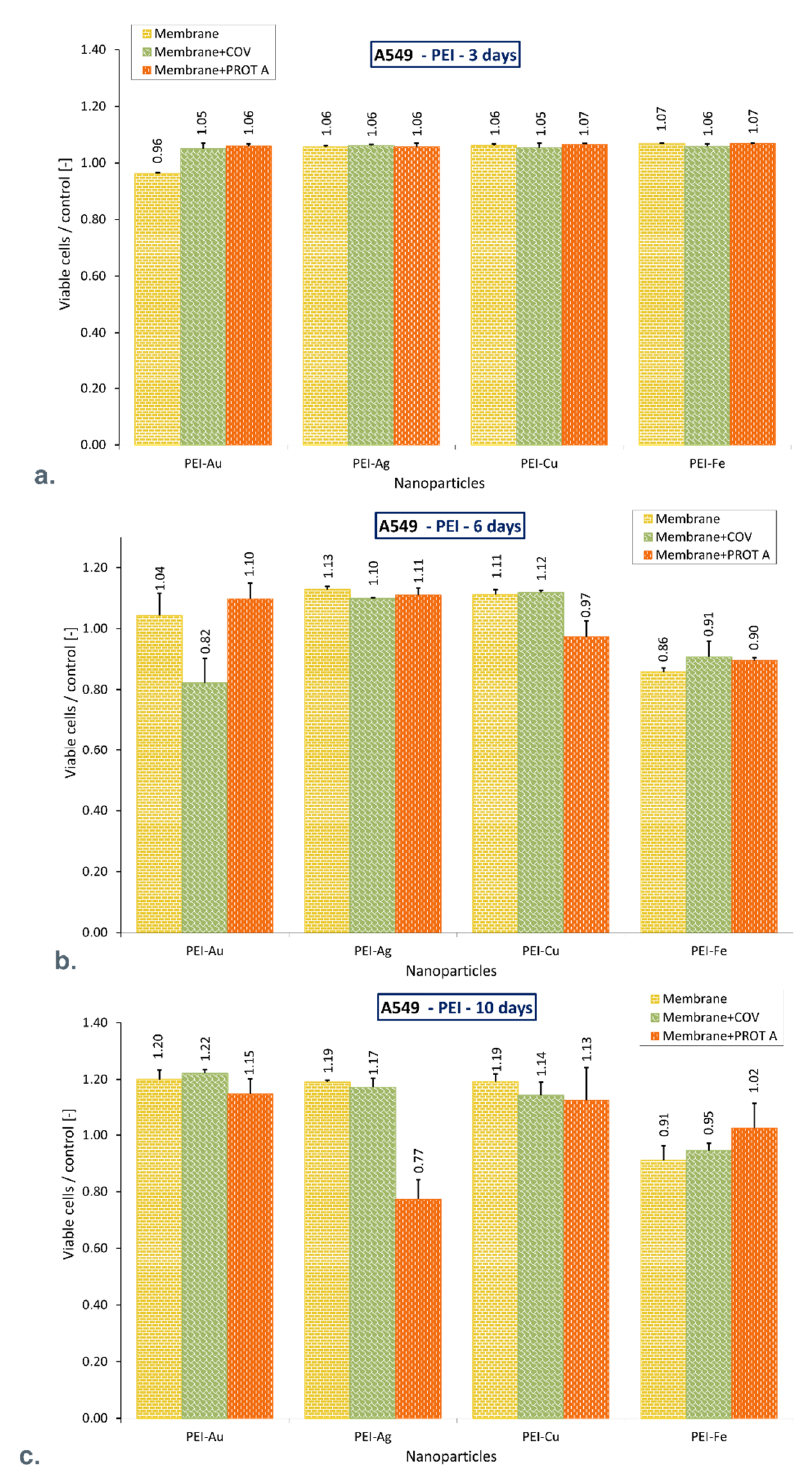
Figure 2. The ratio of the percentage of viable A549 immobilized on membranes to the control after ( a ) 3-day culture, ( b ). 6-day culture, ( c ). 10-day culture. The values are presented as mean ± SD. Key to the symbols: polyethyleneimine membrane with AgNPs incorporated (PEI-Ag), polyethyleneimine membrane with AuNPs incorporated (PEI-Au), polyethyleneimine membrane with CuNPs incorporated (PEI-Cu), polyethyleneimine membrane with FeNPs incorporated (PEI-Fe). Membrane—the membrane without adsorbed COV or PROT A; Membrane + COV—membrane with adsorbed COV; Membrane + PROT A—membrane with adsorbed Protein A.